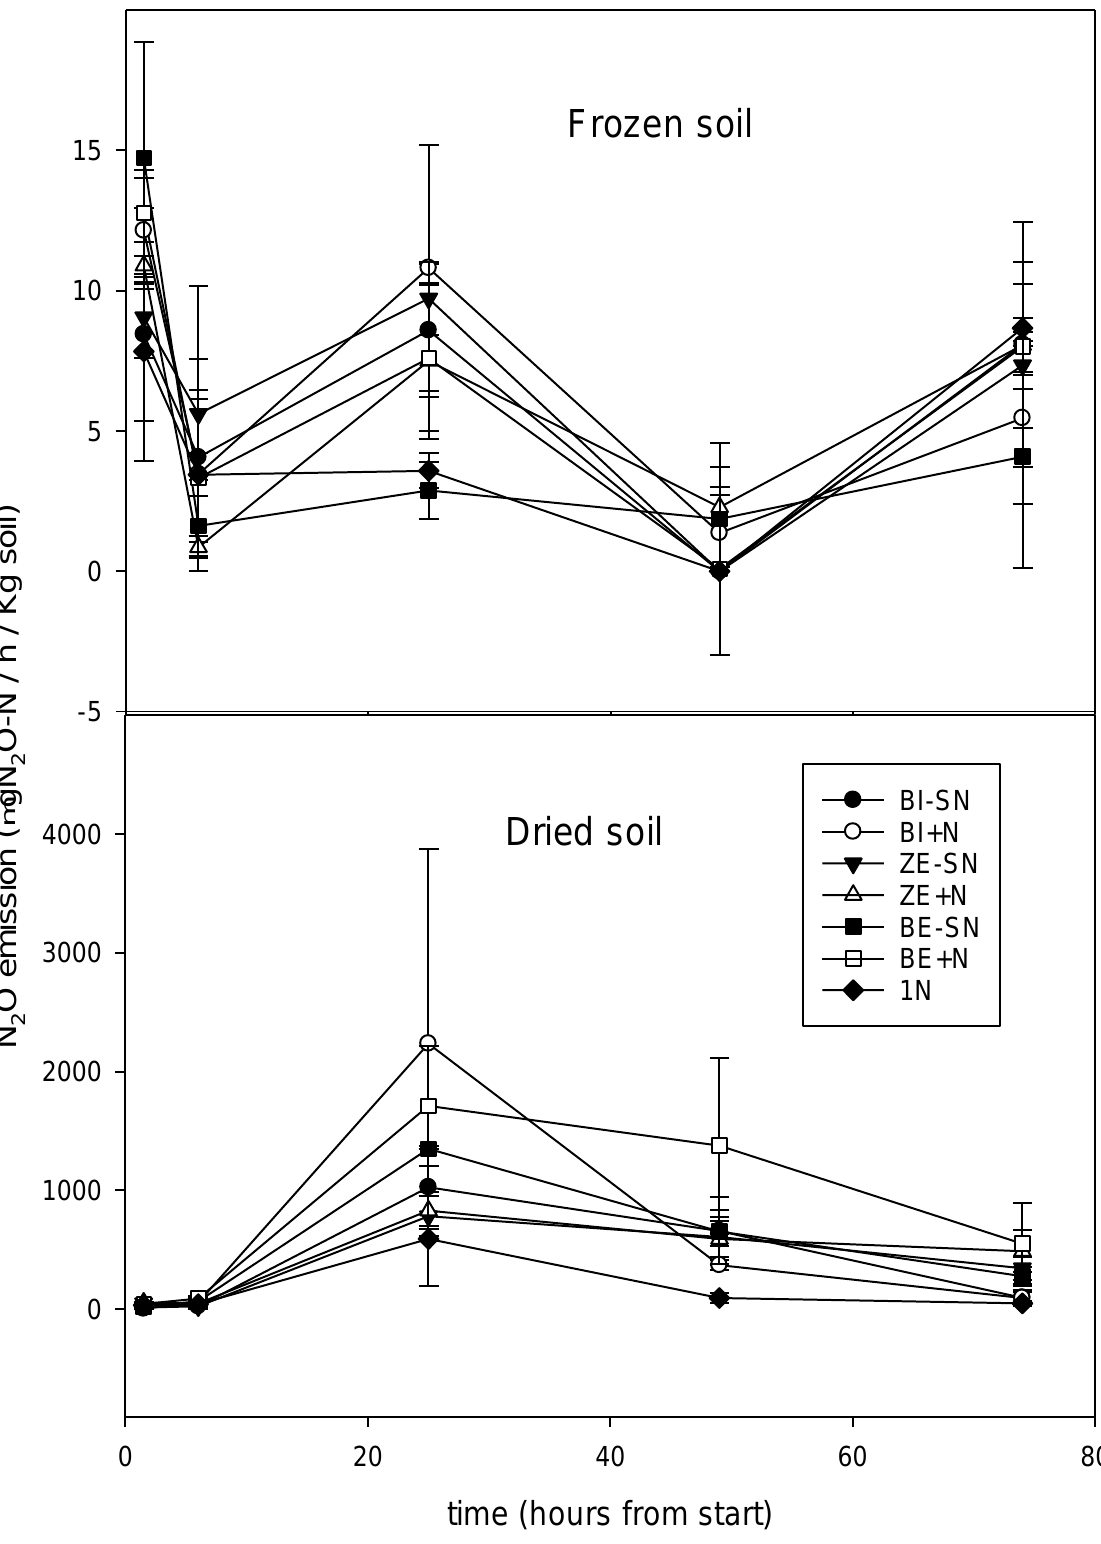
Figure 5. N 2 O emission from soil after thawing and re-wetting. Error bars are standard error (n = 3). 1N = full mineral N fertilizer, no sorbent, BI = biochar sorbent, ZE = zeolite sorbent, BE = bentonite sorbent. When sorbent and N fertilizer are both mixed into the soil separately, -SN is added. When N fertilizer is applied, sorbed with the sorbent +N is added.